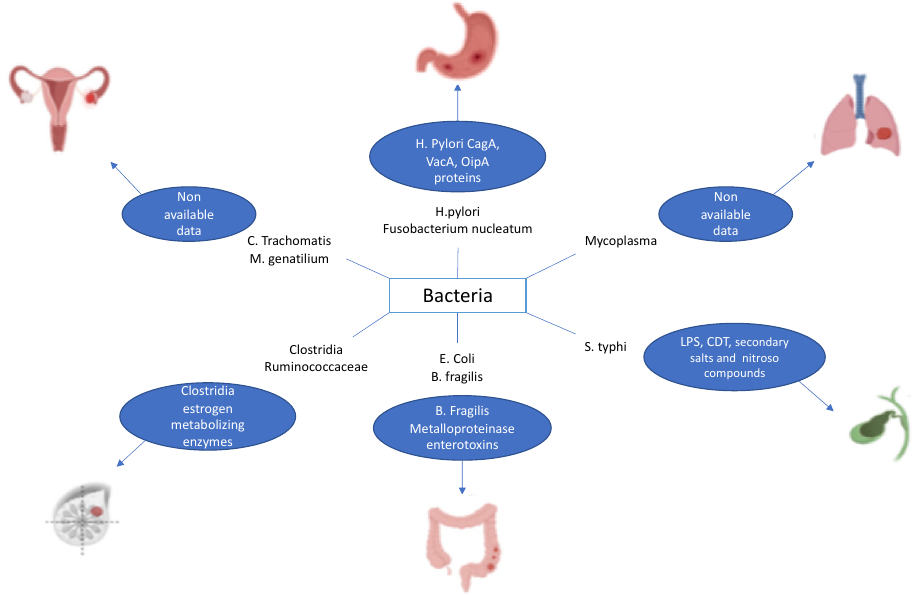
Figure 1. Examples of bacteria causing cancer. The infection by H. pylori can induce DNA mutation by disrupting double-strand DNA breaks, minimizing mismatch repair genes and aberrant DNA methylation, and maximizing activation-induced cytidine deaminase expression [22,23].